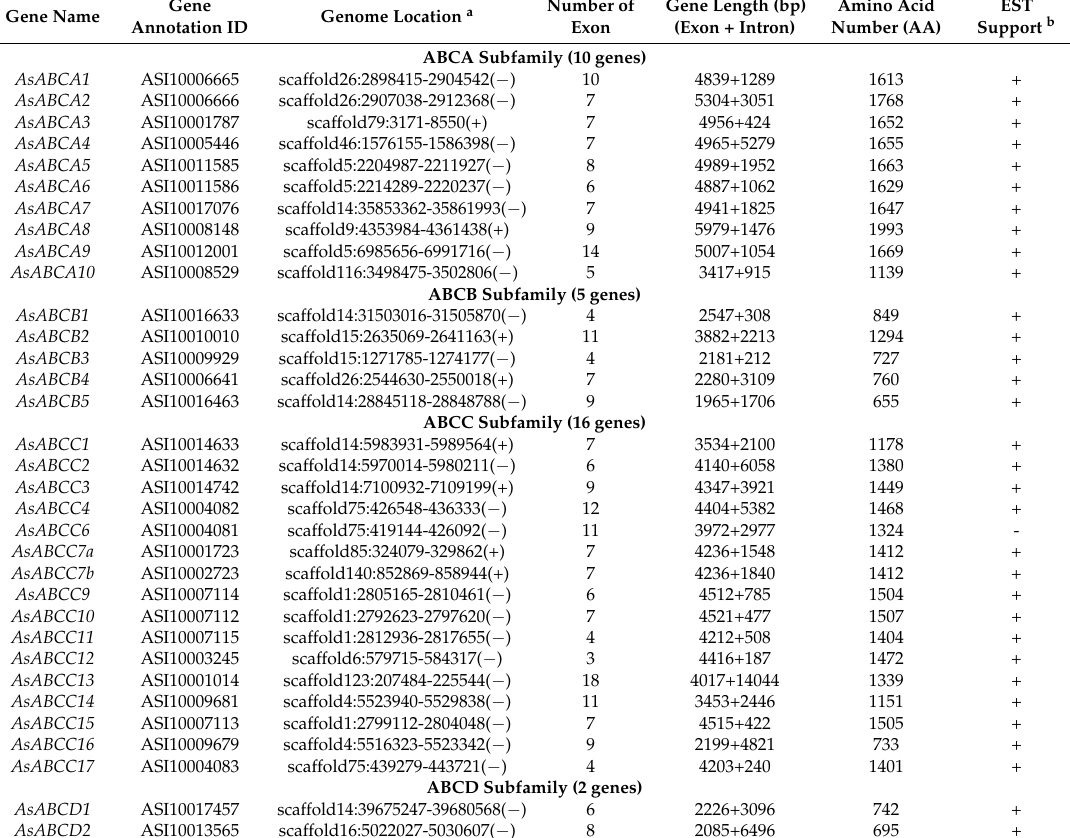
Table 1. Information summary of 61 ABC transporter genes identified in the A. sinensis